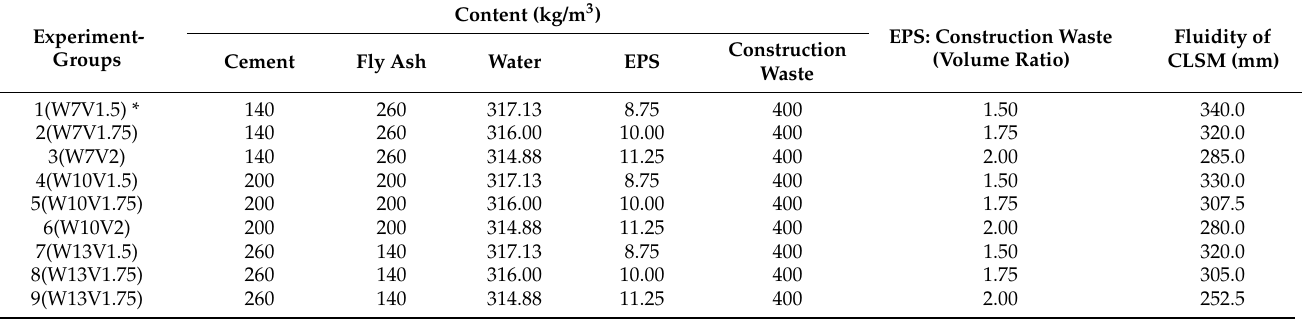
Table 4. Mixing proportion of the EVA modified lightweight CLSM.